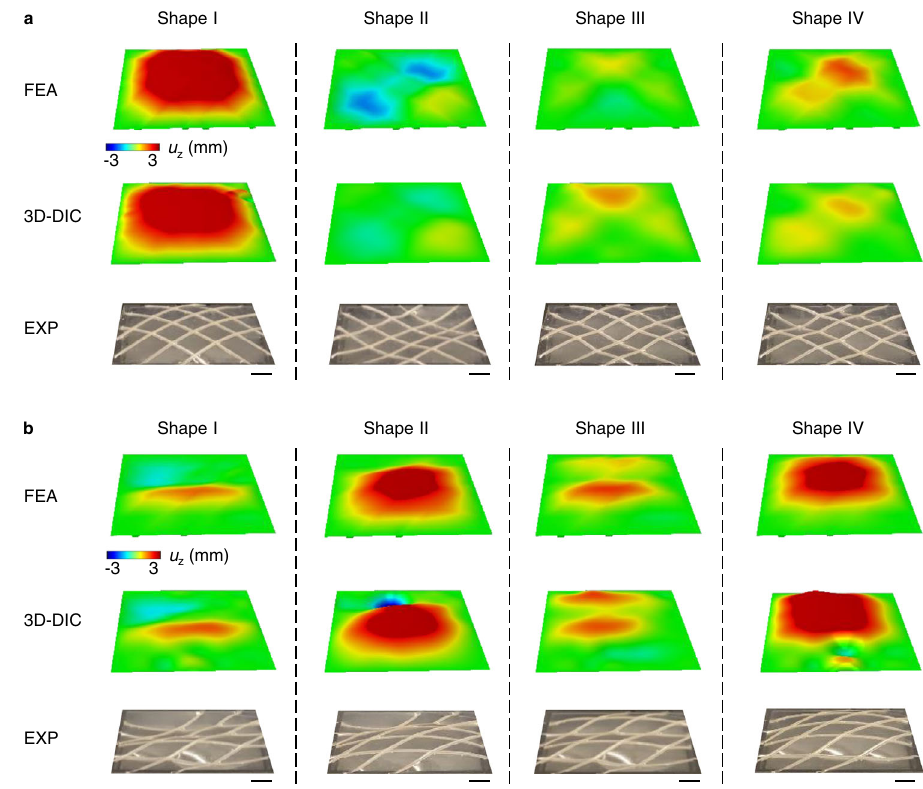
Fig. 2 3D shapes transformed from the programmable surface. a FEA predictions and experimental results (3D-DIC and optical images) of four representative 3D shapes transformed from the programmable surface featuring an orthogonal and symmetric ribbon layout (45°/ − 45°) in a non-uniform magnetic fi eld associated with a single permanent block magnet. b FEA predictions and experimental results (3D DIC and optical images) of four representative 3D shapes transformed from the programmable surface featuring a non-orthogonal and asymmetric ribbon layout (0°/45°) in the same magnetic fi eld as in a . Scale bars, 5